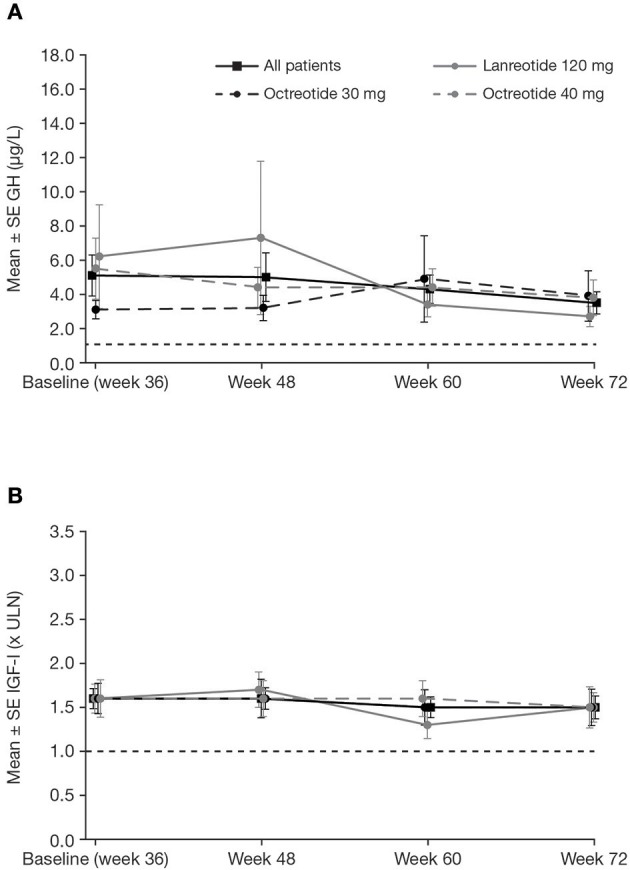
Mean ± SE (A) mGH and (B) IGF-I by visit during the extension, in all patients and by previous first-generation SSA treatment. Reference line is (A) 1.0 μg/L and (B) ULN.